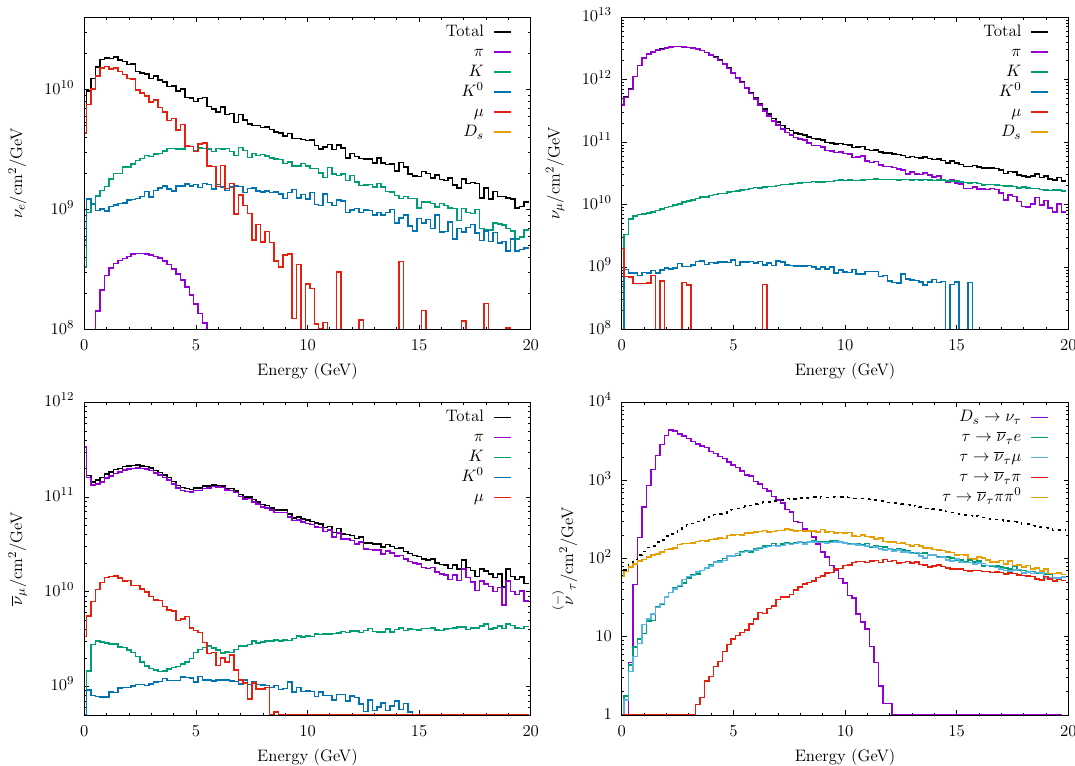
Figure 3 . The prediction of neutrino (cid:13)uxes, in neutrino mode, divided by parentage at the ND are shown above, normalised to 10 20 POT. The (cid:23) e component (top left) predominately originates from (cid:22) + decays; kaon decays are responsible for the high energy part of the spectrum. The (cid:23) (cid:22) component (top right) obtains its main contribution from (cid:25) + decays at low energies, whereas the K + decays are accountable for the long tail of the spectrum. Contributions from D + out of scale for both (cid:23) e and (cid:23) (cid:22) . The distribution of the (cid:23) (cid:22) component (bottom left) is due to negative charged secondary particles which are not successfully de(cid:13)ected by the horn system; the muon contribution is much more relevant than for the (cid:23) (cid:22) component. The (cid:23) (cid:28) component (bottom right) is only sourced from D s decays and presents a prominent peak at low energies, whereas the (cid:23) (cid:28) are produced in (cid:28) + lepton decays. The dotted black line is the total (cid:23) (cid:28) component of the